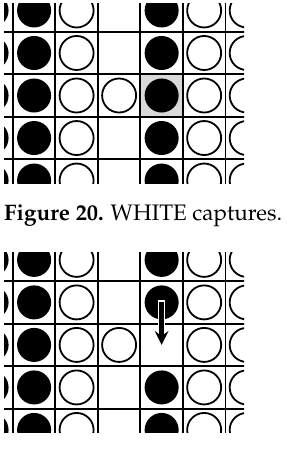
Figure 21. BLACK intrudes.